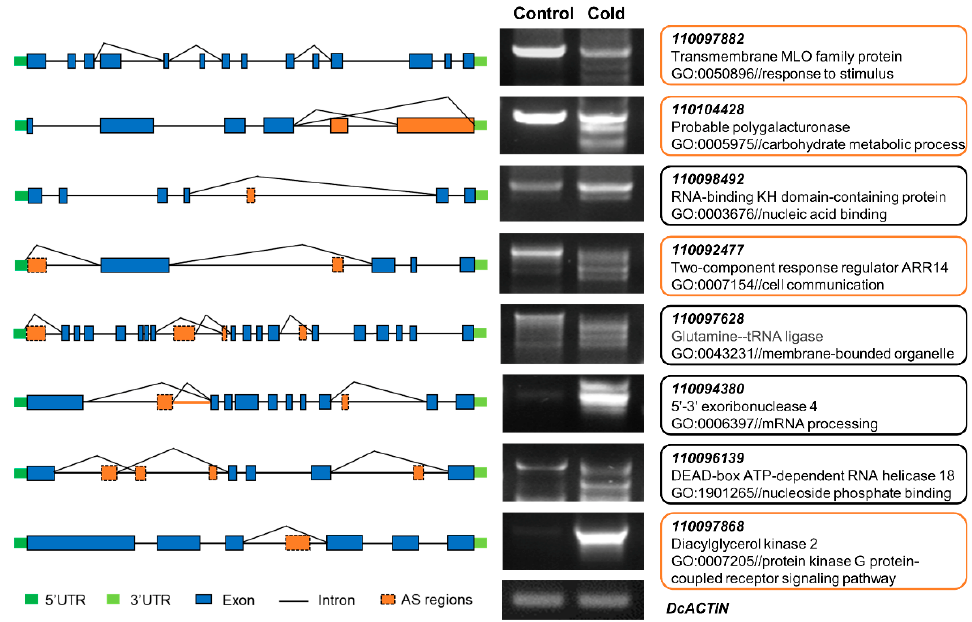
Figure 6. Validation of alternative splicing events in eight selected genes predicted by RNA-Seq through RT–PCR. The left part is gene model diagrams. The medium part is the bands of the products of alternatively spliced genes. DcACTIN was used as an internal control. The right part is the annotation of eight selected genes. The red frames indicate the genes with both different expression level and differential alternative splicing events, and the black frames indicate the genes with only DAS